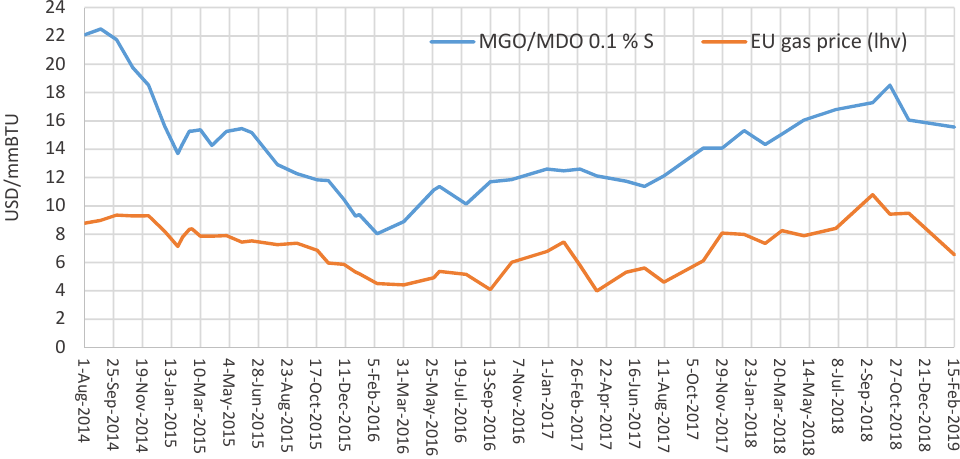
Figure 6. Price development for natural gas and ultra low sulfur MGO/MDO. The price data are retrieved from DNV GL [44]; 1 mmBTU energy equals 1055 MJ in energy; 10 USD/mmBTU is equivalent to approx. 30 EUR/MWh.